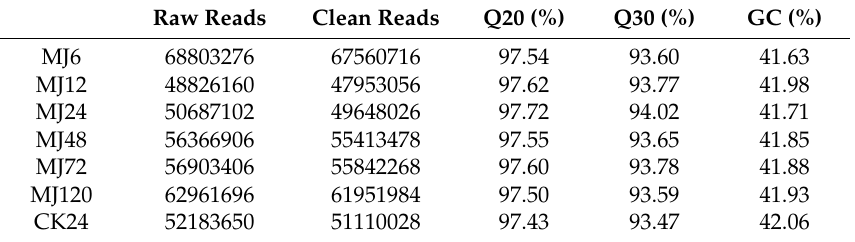
Table 1. Statistic of sequencing and de novo assembling of the T. foenum-graecum transcriptome.